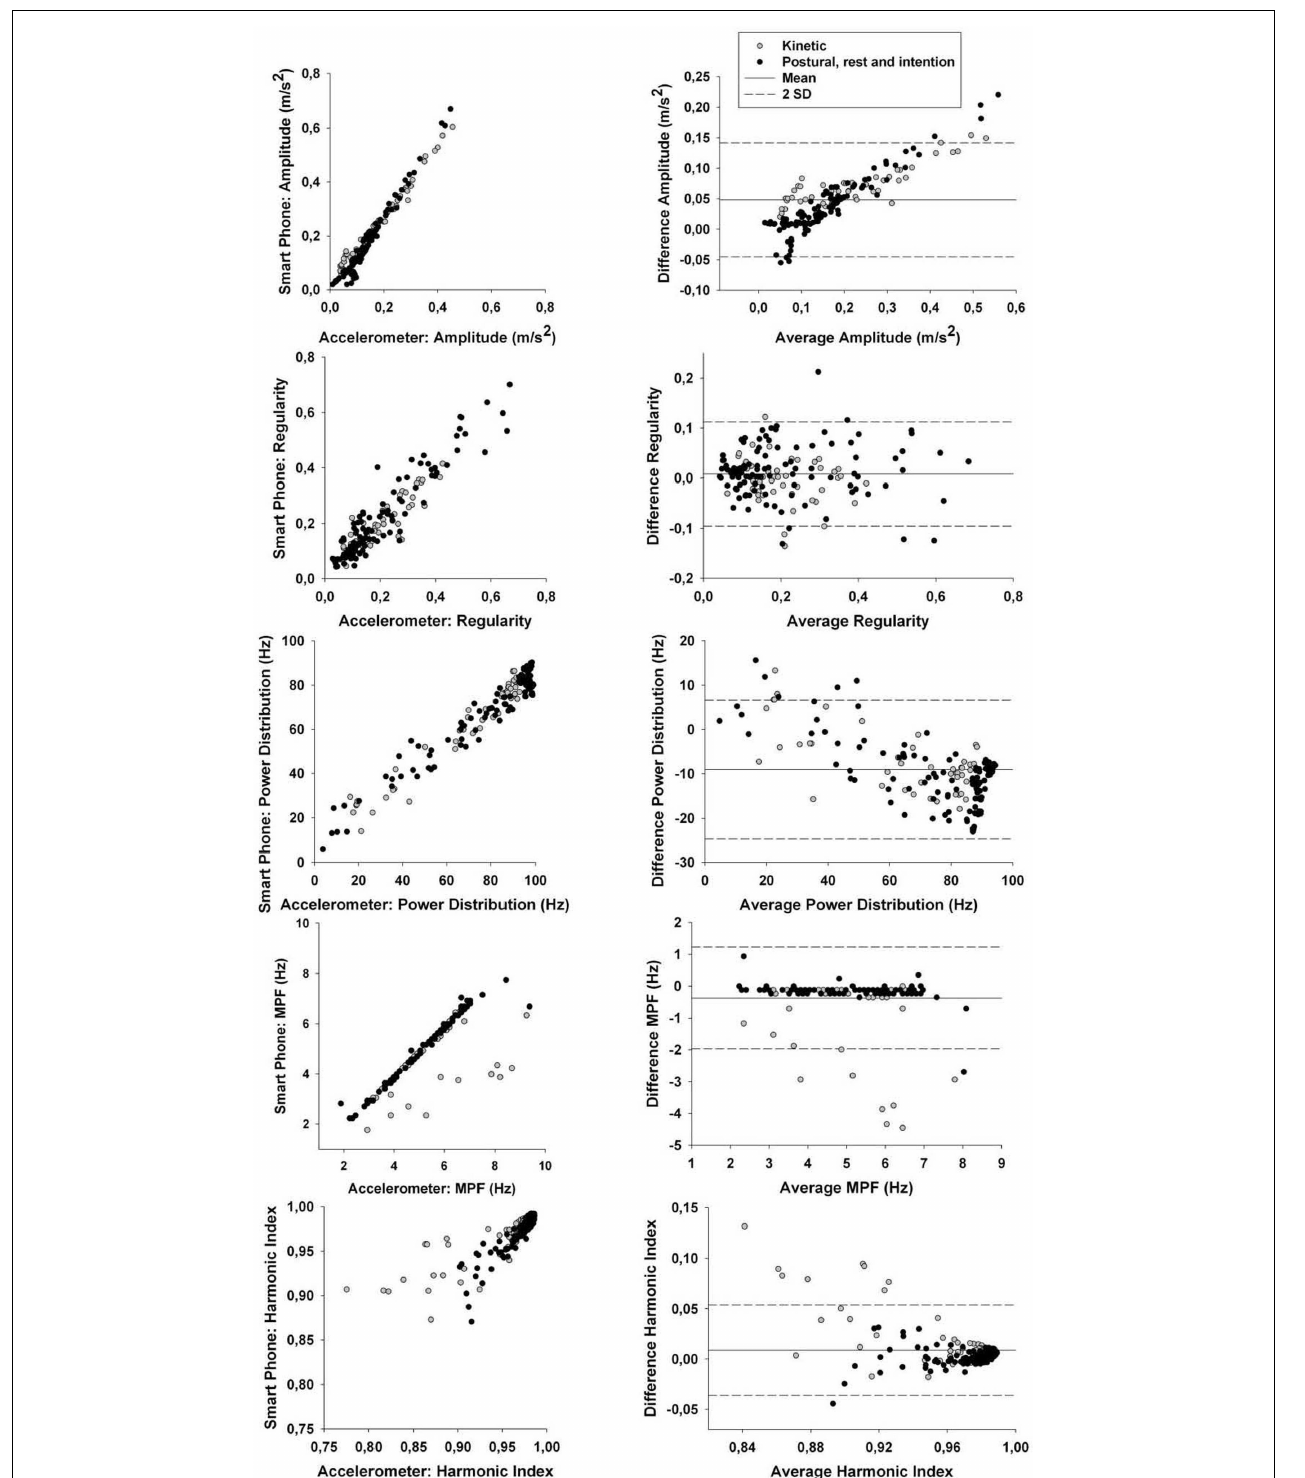
Bland–Altman plots to evaluate the agreement between data from the smart phone and from the accelerometer for tremor amplitude, regularity, power distribution, median power frequency (MPF), and harmonic index (HI). Specific values for the Bland–Altman test (bias, SD) are shown in Table 2